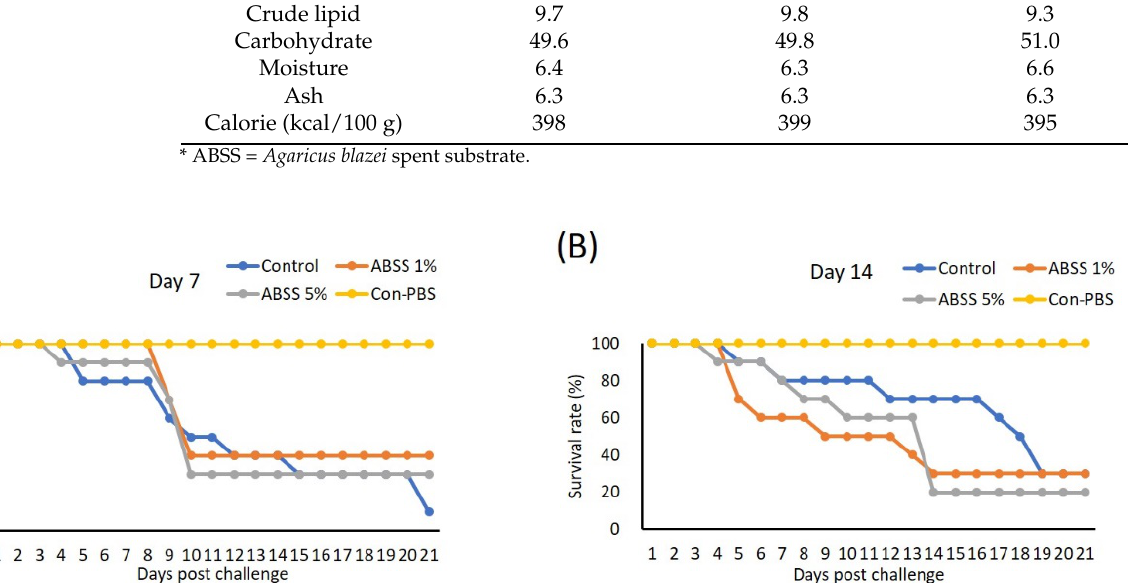
Figure 7. Fish were fed with feed containing 0 (control), 1%, or 5% Agaricus blazei spent substrate (ABSS) for ( A ) 7 and ( B ) 14 days and subjected to Streptococcus agalactiae infection. A control group that injected with phosphate-buffered saline (Con-PBS) was included. Survival percentages were recorded for 21 days. N = 10 per group.